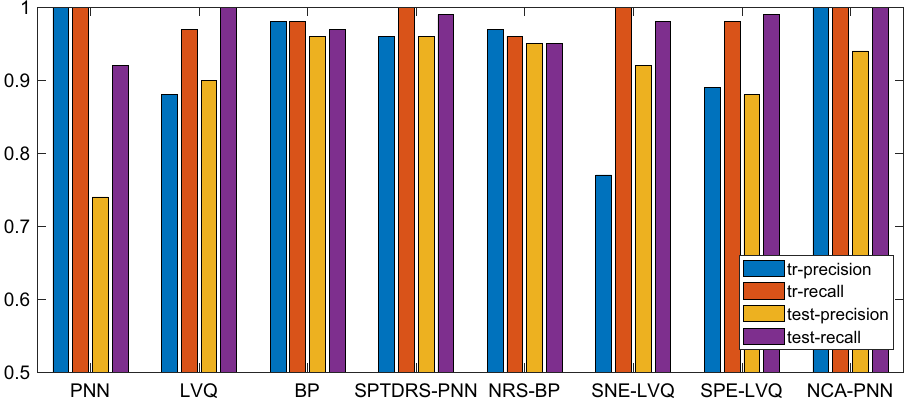
Figure 8. Comparison of precision rate and recall rate of each model.